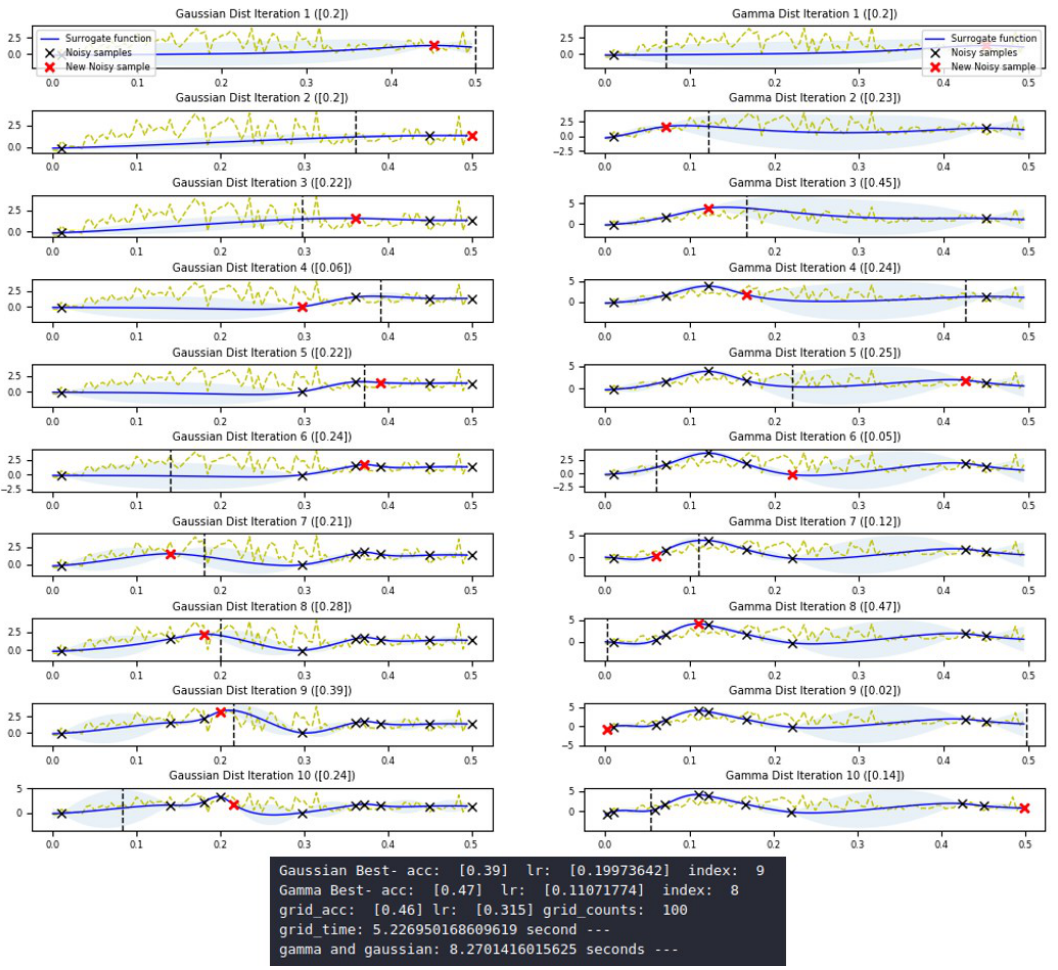
Figure 10. Comparison of Gaussian distribution and Gamma distribution at 1 epoch. The yellow dashed line shows non-free observations of the objective function f at 300 points; that is, the graph of the y value with an input of 100 x values (grid type) directly for the objective function. The blue line is an estimated graph of the objective function for the x values, which is 10 times sequentially calculated using the Acquisition Function. The red x points represent the final predicted points for each